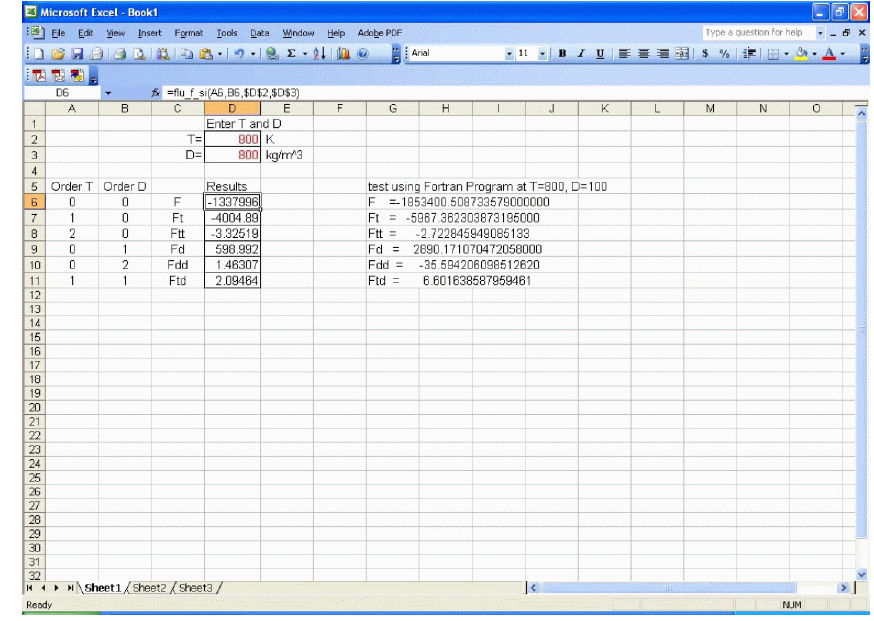
Fig. 4.1: Calling the SIA Helmholtz function of fluid water, flu_f_si , from within a Fig. 2. Calling the SIA Helmholtz function of fluid water, flu f si , from within a spreadsheet application. spreadsheet application. to disable or enable range checking, shown in Fig 4.2.